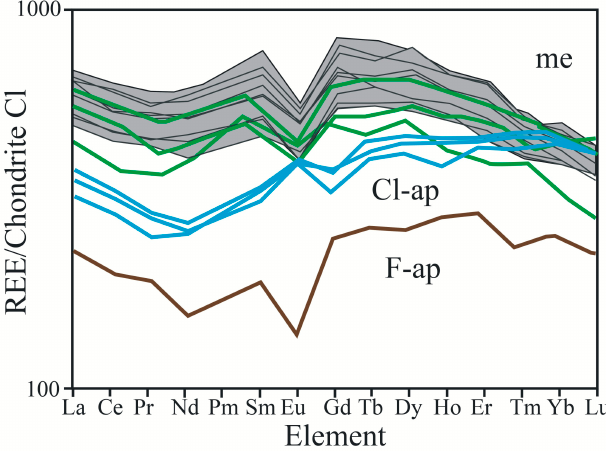
Figure 5. Chondrite-normalized REE patterns for the F-apatite (brown), Cl-apatite (blue) and merrillite (grey area). For comparison, merrillite REE patterns from other shergottite after [41] (green).